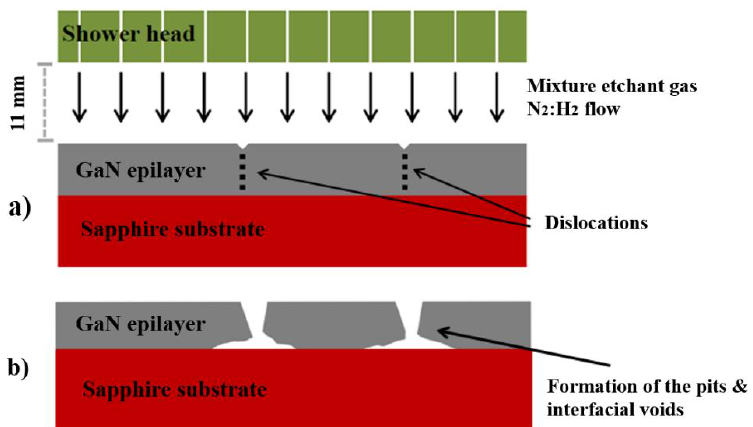
Figure 1. Schematic illustration of a GaN layer grown on a sapphire substrate in a metal organic vapor phase epitaxy (MOVPE) reactor at the end of the growth process; ( a ) exposed to N 2 : H 2 etchant gases to be etched along the dislocation lines, and ( b ) formation of pits because of dislocation etching and subsequently formation of voids along the GaN / sapphire interface.